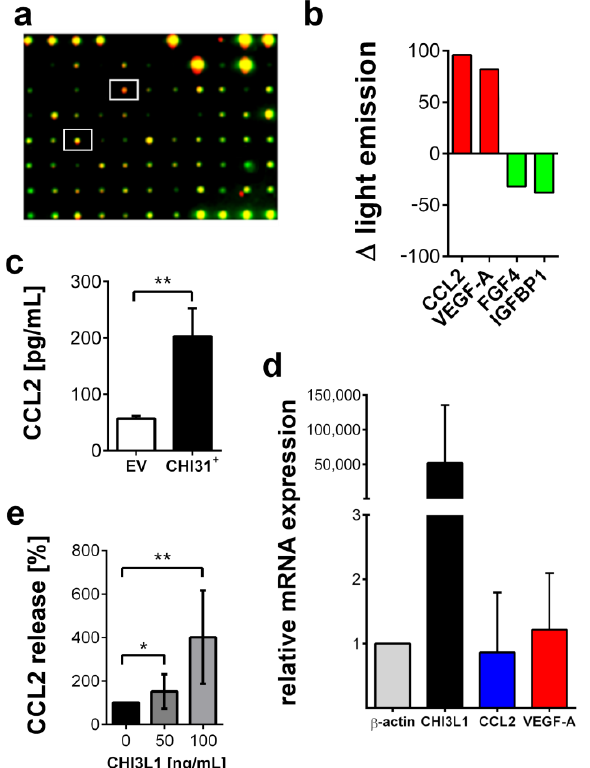
5 of 14 Figure 3. CHI3L1 promoted the migration of BLM cells and altered their secretome. ( a ) Repre- sentative bright-field microscopic images of the performed scratch assays with BLM cells. Treat- ment of BLM cells with 50 or 500 ng/mL CHI3L1 for 24 h. Scale bar = 100 µm. n ≥ 6; * = p ≤ 0.05 one- way ANOVA. ( b ) Treatment of Ret cells with 50 and 500 ng/mL CHI3L1 ( c ) Scratch assay with Ret cells treated with conditioned cell culture medium harvested from BLM cells. Supernatants from BLM cells overexpressing recombinant CHI3L1 (CHI3L1 + ) were compared to supernatants from empty vector-transfected BLM cells (EV). Ret cells cultivated in medium without FCS (RPMI) and Ret cells cultivated in medium containing 10% FCS (FCS) were used as experimental controls. Scale bar = 100 µm. n ≥ 20; ** = p ≤ 0.01 one-way ANOVA. ( d ) Transmigration assay analyzing the transmigration of Ret cells towards EV transfected BLM cells or CHI3L1 expressing BLM cells. n = 9; ** = p ≤ 0.01 Student’s t -test. 2.3. CHI3L1 Altered the Composition of the Tumor Cell Secretome In the next set of our experiments, we used a proteome microarray to compare the composition of the BLM CHI3L1+ conditioned medium with the conditioned medium of the BLM EV cells. CHI3L1 overexpression increased the levels of CCL2 and VEGF-A in the conditioned medium (Figure 4a,b). Independent ELISAs confirmed the significant in- crease in CCL2 (Figure 4c). Increased levels of CCL2 and VEGF-A were not coupled to an increased gene transcription as indicated by the qRT-PCR results shown in Figure 4d. These data suggest that CHI3L1 can increase the levels of growth factors and cytokines in